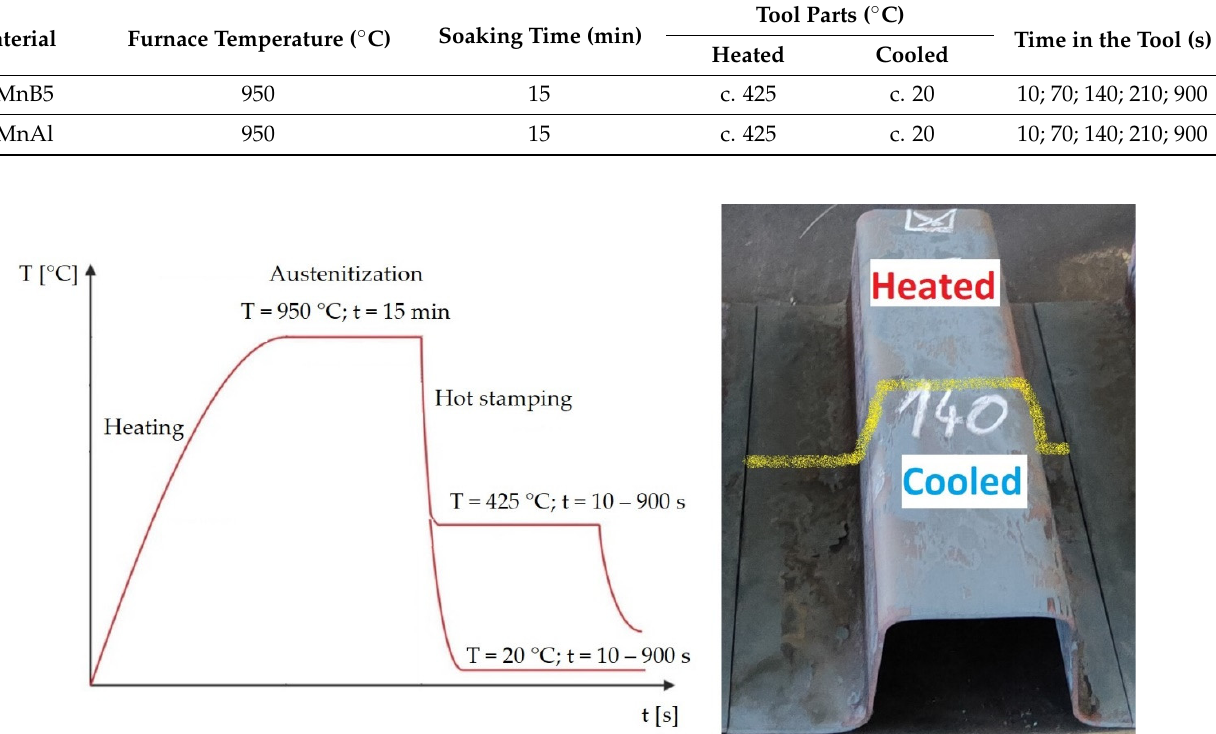
Figure 5. Heating curves for both parts of the sheet and the final shape of the omega